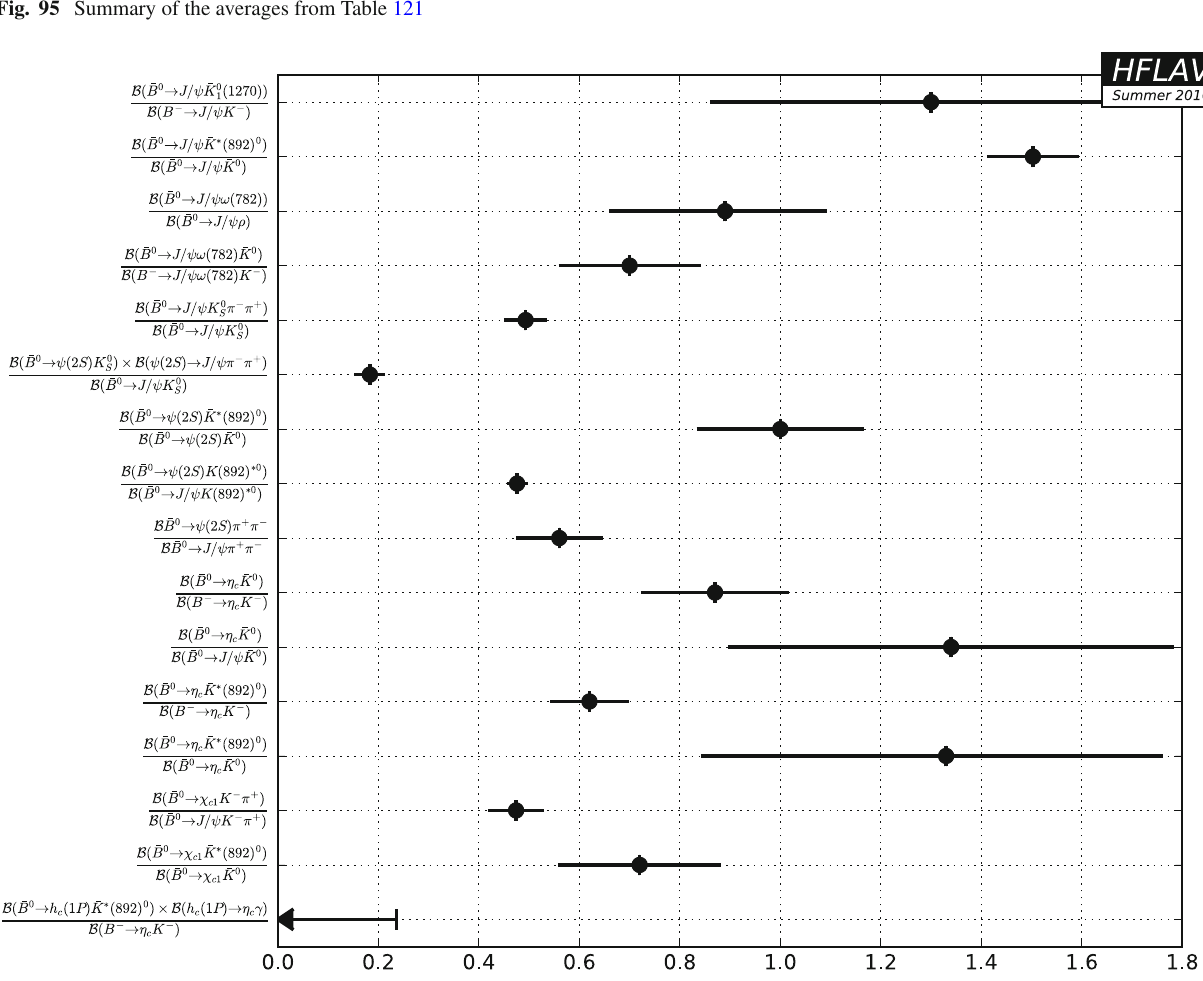
Fig. 95 Summary of the averages from Table 121